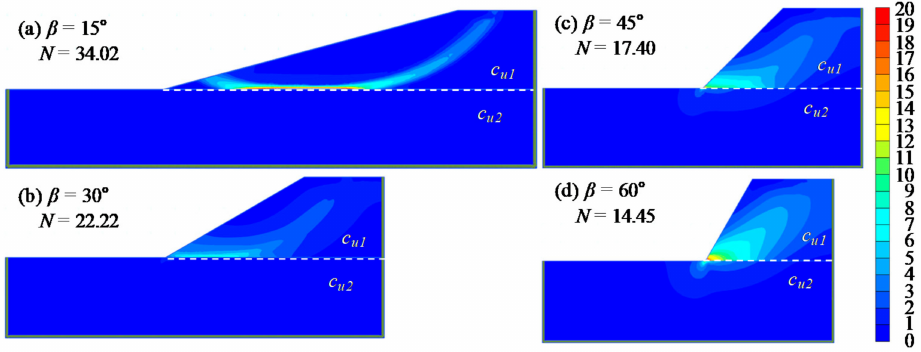
Figure 8. Total deviatoric strain according to the angle of inclination, where D / H = 1.0, H / B = 0.5, c u 1 / c u 2 = 0.25, T / H = 2.0, ( a ) β = 15 ◦ , ( b ) β = 30 ◦ , ( c ) β = 45 ◦ , and ( d ) β = 60 ◦